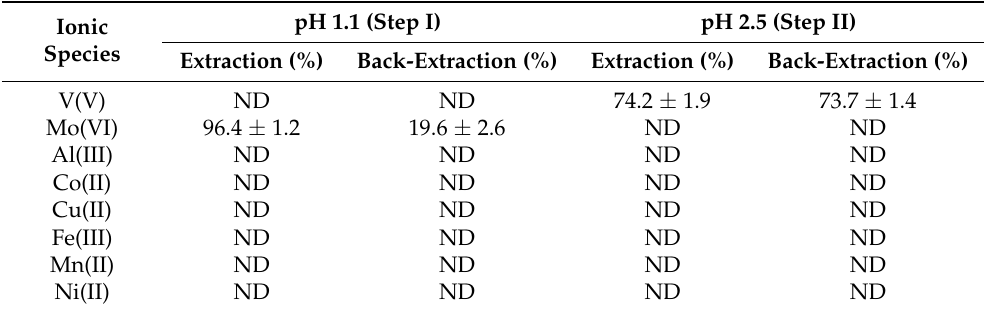
Table 3. Results of a two-step extraction/back-extraction procedure for the selective PIM-based separation of V(V) from a source solution containing Mo(VI), Al(III), Co(II), Cu(II), Fe(III), Mn(II) and Ni(II) (50 mg L − 1 each) a,b . pH 1.1 (Step I)